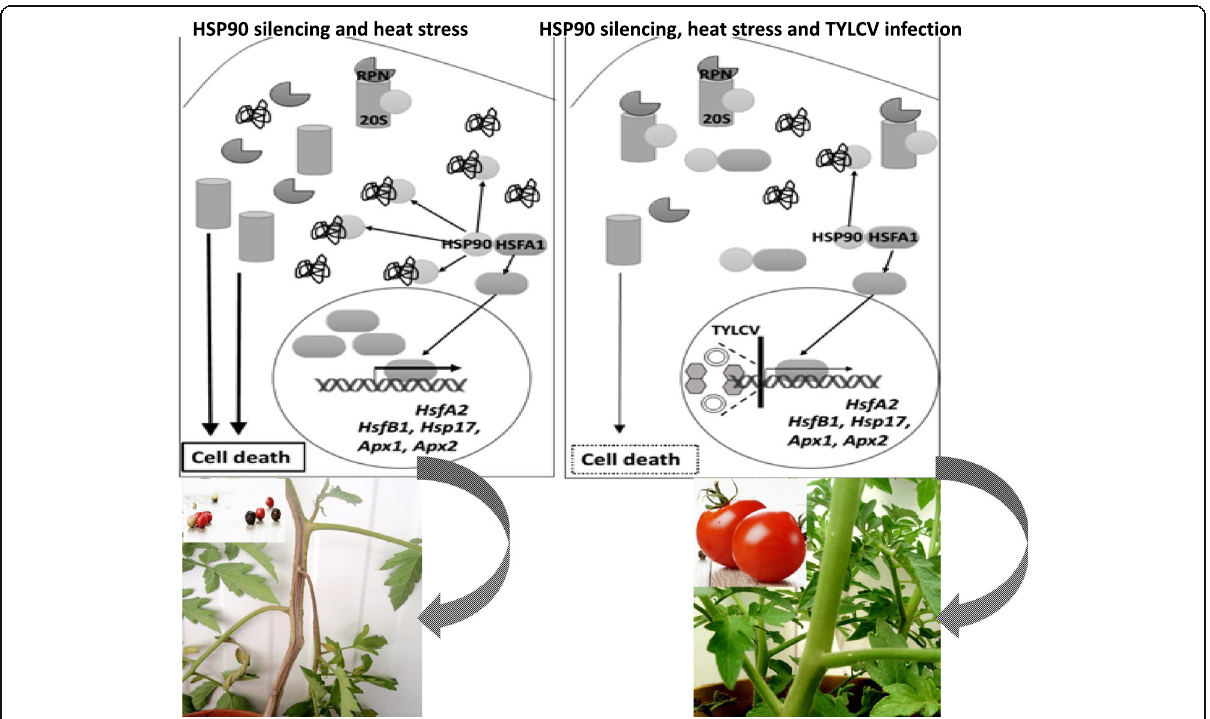
Fig. 1 Summary of the key processes of stress response regulation by HSP90 in tomato plants, and down-regulation by TYLCV infection. Functional loss of the cellular chaperone HSP90 causes the dissociation of the 26S proteasome and a significant decrease of its peptidase activity, consequently, to an increase in the level of ubiquitinated proteins and cell death signs. The inhibition of the 26S proteasome stimulated the expression of heat-inducible genes, including transcription factor HSFA2, in the plant and mammals cells. The involvement of HSP90 in the regulation of signal transduction via HSFA2 activation was demonstrated in several plant species, including tomatoes (Hahn et al. 2011). We have shown that in tomatoes, the levels of HSFA2 were rather low in leaves of uninfected tomato plants. The amounts of HSFA2 greatly increased upon heat stress in uninfected tissues, and much less in TYLCV-infected leaves. The inhibition of HSP90 activity caused an additional increase in HSFA2 expression. Subsequent TYLCV infection reduced HSFA2 levels as well as the expression levels of HsfB1 , Hsp17, Apx1, and Apx2 (Moshe et al. 2016). TYLCV infection (represented as virions and viral DNA) suppresses HSP90-dependent 26S proteasome inactivation, cell death and HSFA2 signal transduction pathways, resulted in wealthy growth and yielding of